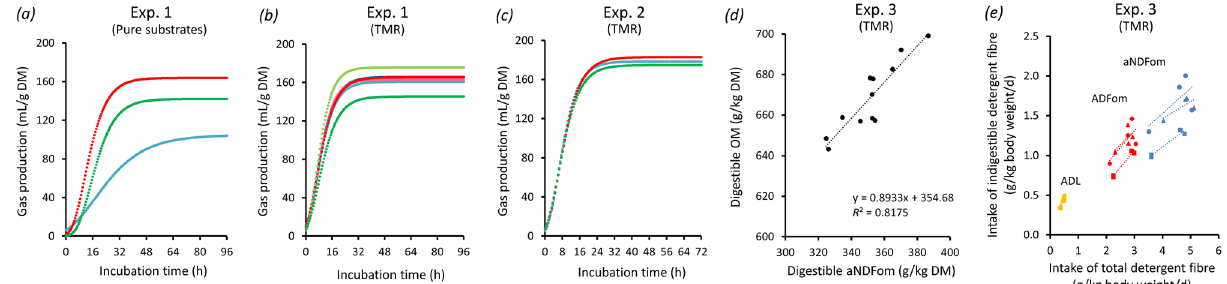
Figure 2. Gas production profiles from incubation of pure straw treatments ( a ), a model TMR composed of 45% barley grains, 2% soybean meal, and 53% lucerne chaff and model TMR including the straw treatments with 10 or 20% of the proportion of lucerne chaff (Experiment 1) ( b ), and practical TMR composed of 33.5% maize silage, 21.6% rapeseed meal, 26.7% barley grains, and 18.2% of one of the straw treatments on DM basis in the in vitro batch culture system (Experiment 2) ( c ). Linear relationship between digestible OM and digestible aNDFom concentration of the practical TMR (Experiment 3) ( d ). Linear regression between intake, by sheep, of indigestible detergent fibre and intake of total detergent fibre from the practical TMR (Experiment 3) ( e ). Legend: ( a , c ) untreated straw, NaOH treated straw, urea treated straw; ( b ) basal TMR, untreated straw (10%), untreated straw (20%), NaOH treated straw (10%), NaOH treated straw (20%), urea treated straw (10%), urea treated straw (20%). The straw treatments and conducted experiments are specified in the text. ADFom, acid detergent fibre expressed exclusive of residual ash, ADL, acid detergent lignin; aNDFom, amylase- treated neutral detergent fibre expressed exclusive of residual ash; DM, dry matter; OM, organic matter; TMR, total mixed